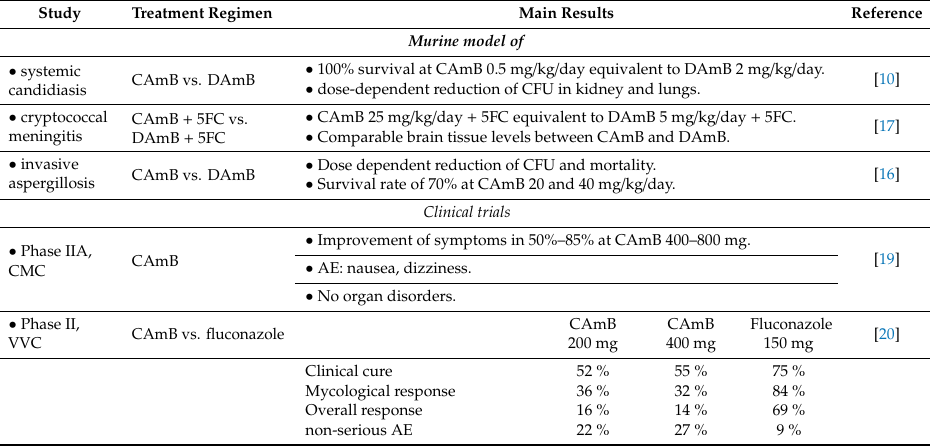
Table 1. Overview of in vivo data obtained from murine models and clinical